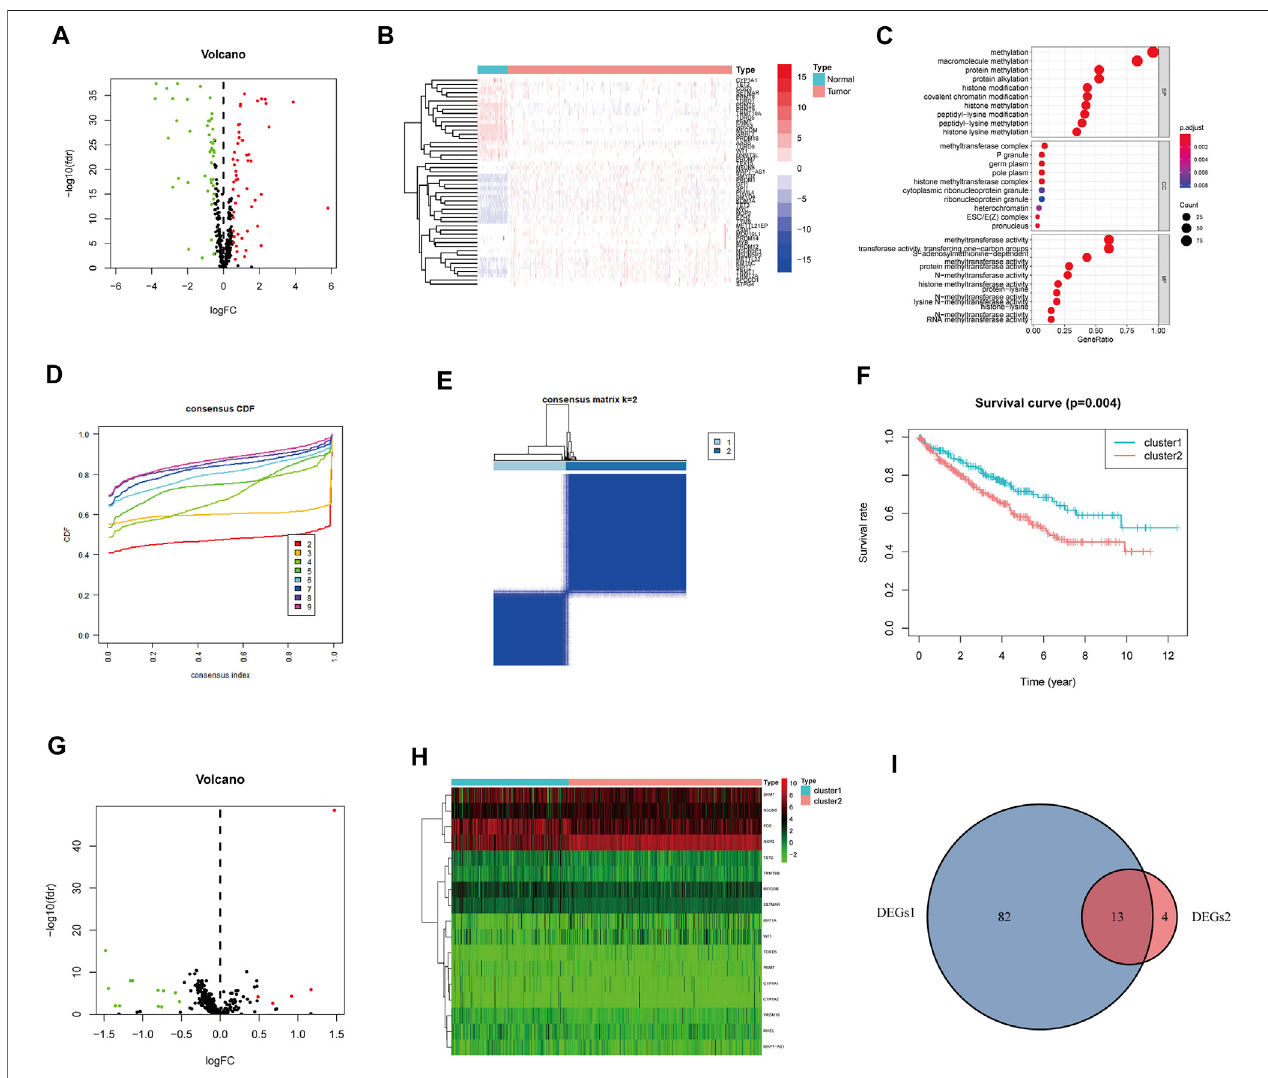
FIGURE 2 | Identi fi cation of methylation-regulating Hub Genes. (A) Volcano plot demonstrates DEGs1. (B ) Heatmap demonstrates the top 50 DEGs1. (C) The GeneOntology(GO)analysisofDEGs1inccRCC. (D) Consensusclusteringcumulativedistributionfunction(CDF)fork=2to9. (E) Theconsensusheatmapshowedthe ccRCC patients was divided into two distinct clusters when k = 2. (F) Overall Survival (OS) analysis of different clusters in the TCGA dataset. (G) Volcano plot demonstrates the DEGs2. (H) Heatmap demonstrates the DEGs2. (I) Venn diagram demonstrates the intersect between DEGs1 and DEGs2.